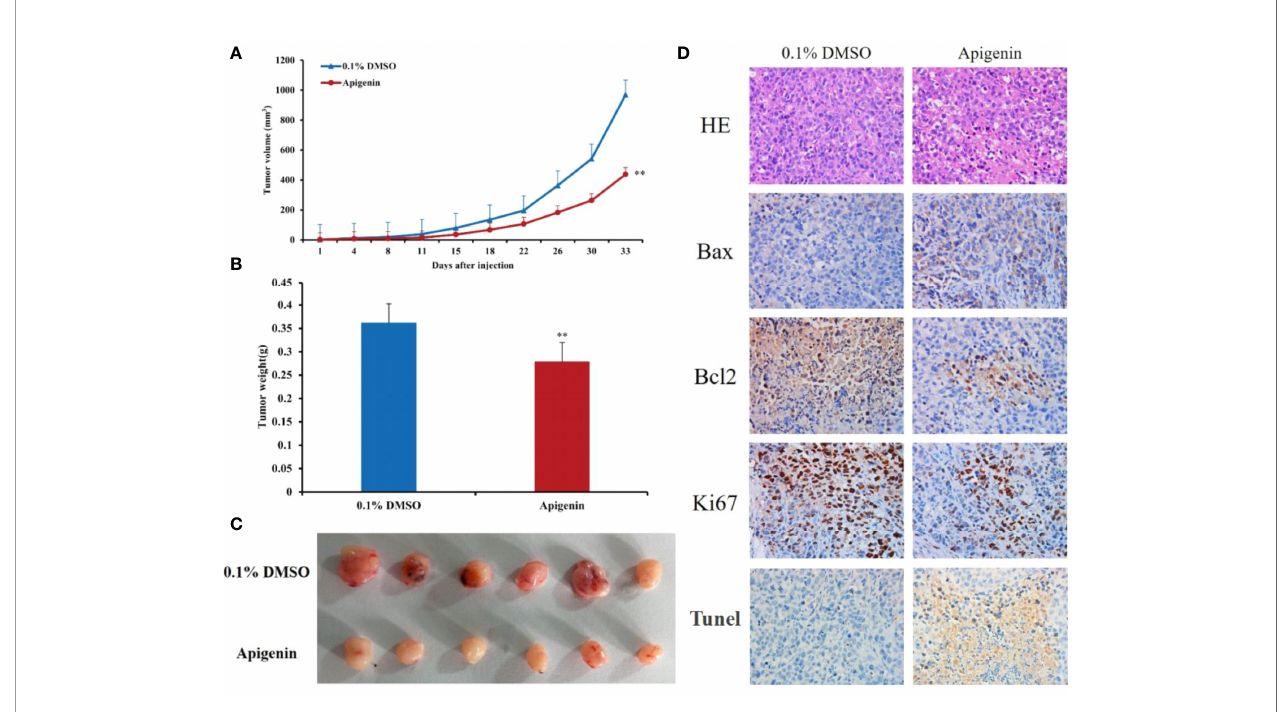
FIGURE 2 | Effects of apigenin on the tumorigenicity of Huh7 xenograft in nude mice. (A) Tumor growth curves of Huh7 cells treated with apigenin (25 mg/kg/day) or vehicle control (0.1% DMSO). (B) Tumor masses of each treatment group. (C) Photographs of resected tumors (n = 6) from each treatment group. (D) Representative tumor sections stained with H&E, anti-Bax, anti-Bcl2, anti-Ki67 antibodies and Tunel assay kit. Original magni fi cation: ×400. ** P < 0.01 in comparison to the control treatment (0.1% DMSO)